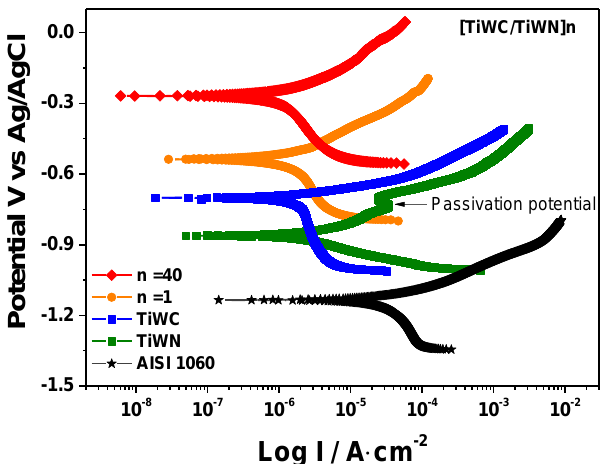
Figure 6. Potentiodynamic curves of the substrate and coated samples in 3.5 wt.% NaCl solution. The n = 1(orange line) coating presented spontaneous symmetry in the anodic and ca- thodic regions. The E corr value of − 0.55 V tends to be positive, and the i corr of 2.0 × 10 − 6 A · cm 2 decreased compared to the bare substrate. For the n = 40 coating (red line), the E corr was − 0.26 V and the i × 10 − 6 A · cm 2 . Thus, it can be considered that the material corr was 9.2